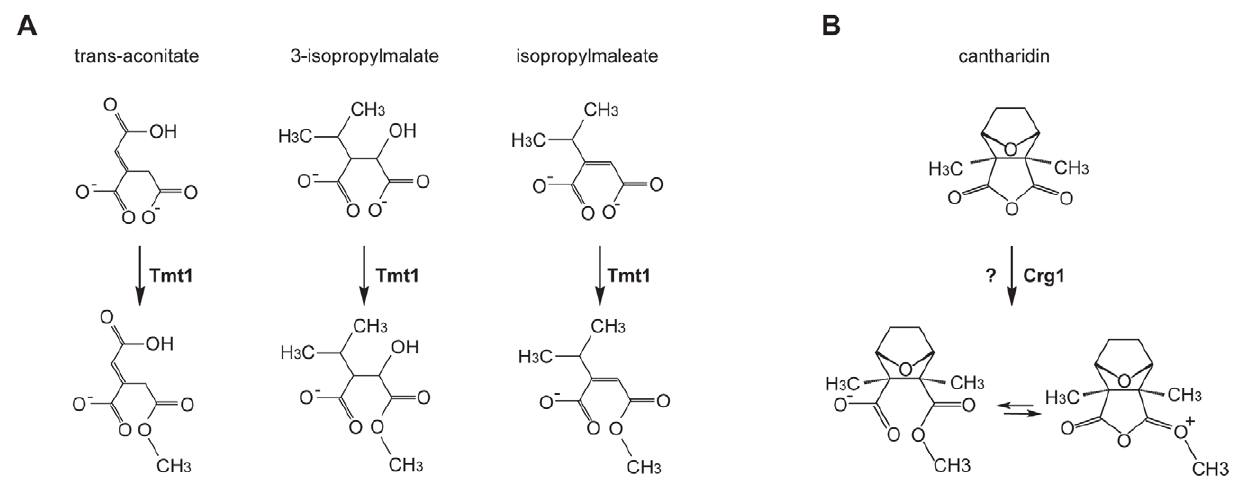
Figure 2. Small molecule methyltransferase TMT1 is a sequence homolog of Crg1. (A) Tmt1, a sequence homolog of Crg1, modifies small molecule intermediates of TCA cycle ( trans -aconitate) and leucine biosynthesis (3-isopropylmalate and isopropylmaleate) to form methyl esters. (B) Hypothetical methylation of cantharidin by Crg1.